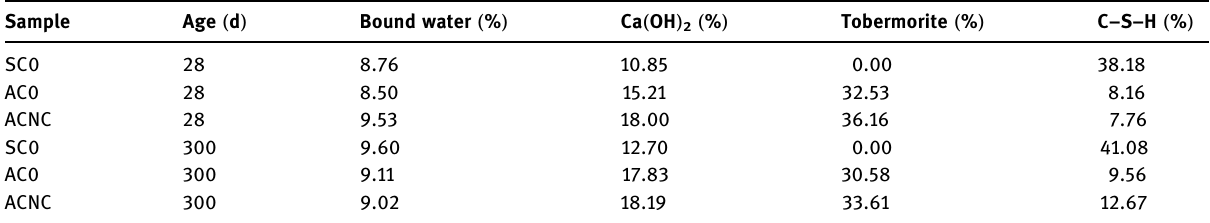
Table 3: Main hydration products of di ff erent cement samples based on TG tests